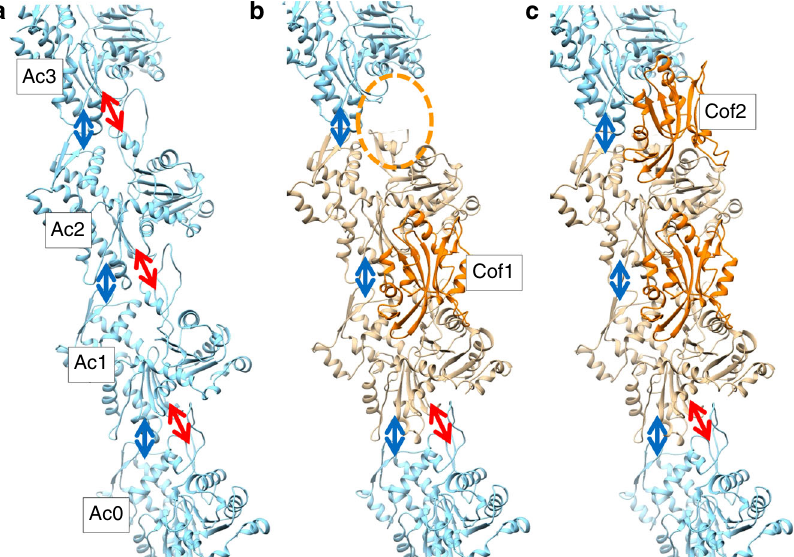
Fig. 6 Model for cooperative binding of co fi lin to the actin fi lament. The P-end is at the top. a One strand of F-actin. The ID – ID and OD – ID intrastrand interactions are presented by blue and red arrows, respectively. b Model of one co fi lin (Cof1) binding to Ac1 and Ac2. Ac1 and Ac2 are replaced by the co fi lactin structure by aligning the inner domains of the actin subunits. Because of the structural transition of Ac2, the OD – ID interaction between Ac2 and Ac3 is eliminated, creating a space (orange ellipse) for Gi-site binding of another co fi lin (Cof2). The form of each actin subunit, C-form or F-form, is indicated in camel and cyan, respectively. At the boundary of Ac1/Ac0, the ID – ID and OD – ID intrastrand interactions between the actin subunits (Fig. 5a, blue and red arrows, respectively) remain because there was no signi fi cant structural change inside the ID of Ac1 (C-form) from the F-form and because Ac0 is in the F-form. c Model of Cof2 binding to the Gi-site of Ac3 in